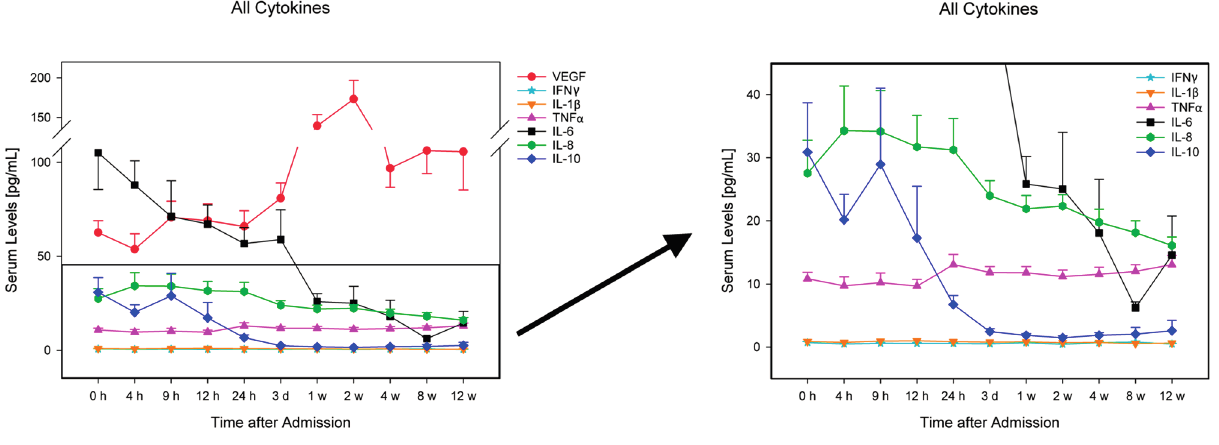
Figure 3. Serum levels of IFN γ , TNF α , IL-1 β , IL-6, IL-8, IL-10, and VEGF in all traumatic SCI patients ( n = 40) over a 12-week period, expressed as m ean ± standard mean error. Abbreviations: h = hours; d = day; w =